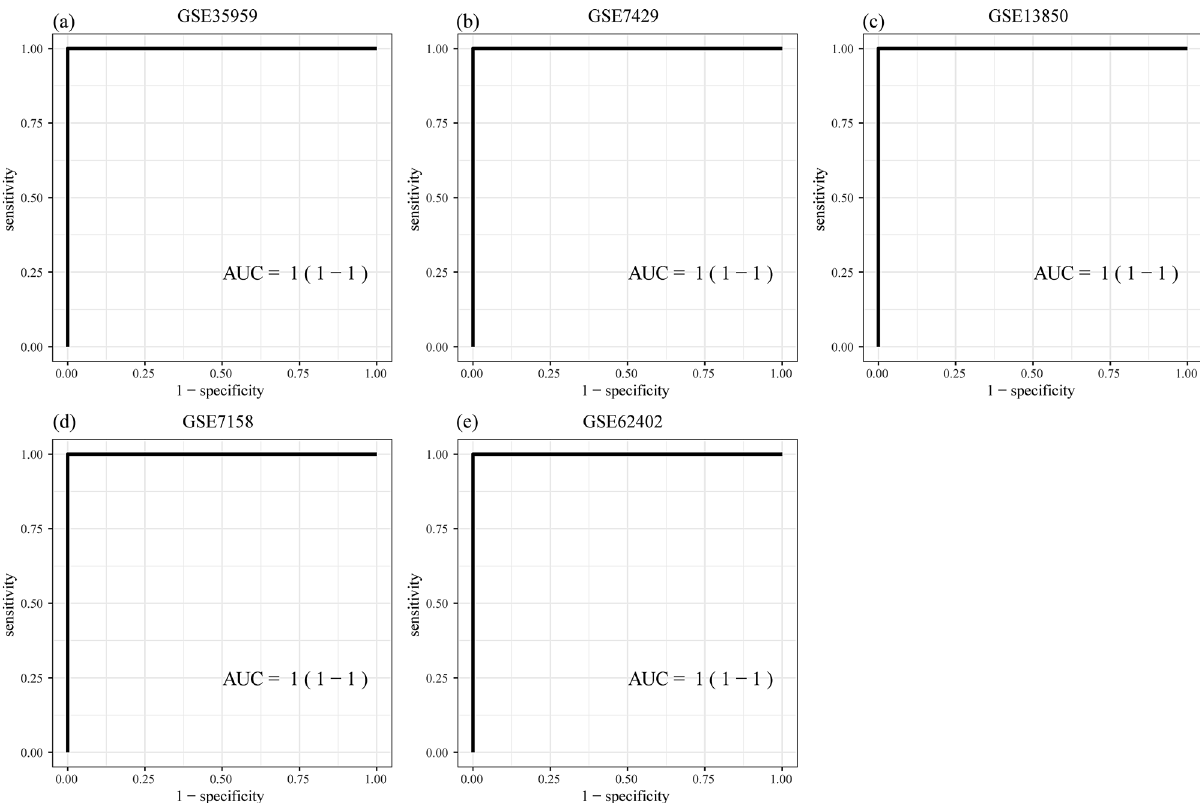
Figure 9: Construction and validation of diagnostic models: ( a ) ROC curves of the classi fi cation results of the diagnostic model on sample of GSE35959 dataset, ( b ) ROC curves of the classi fi cation results of the diagnostic model on the samples of GSE7429 dataset, ( c ) ROC curves of the classi fi cation results of the diagnostic model on the samples of GSE13850 dataset, ( d ) ROC curves of the classi fi cation results of the diagnostic model on the samples of GSE7158 dataset, and ( e ) ROC curves of the classi fi cation results of the diagnostic model on the samples of GSE62402